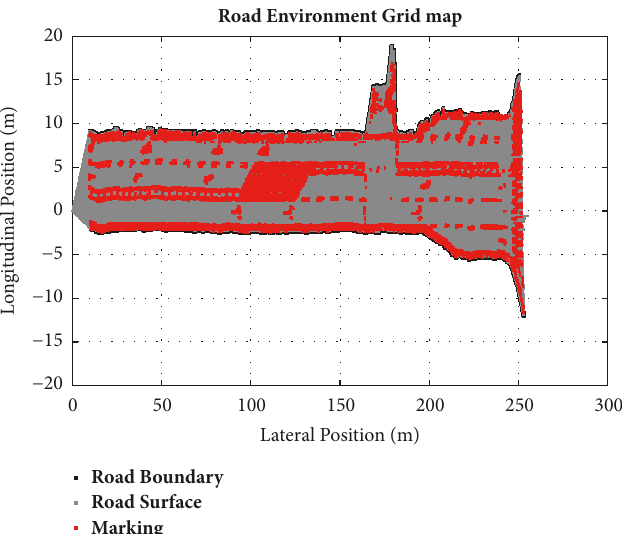
Figure 7: Road environmentgrid map. The road boundary is shown in black, the road surface in gray, the lane markings in red, and unknown space in